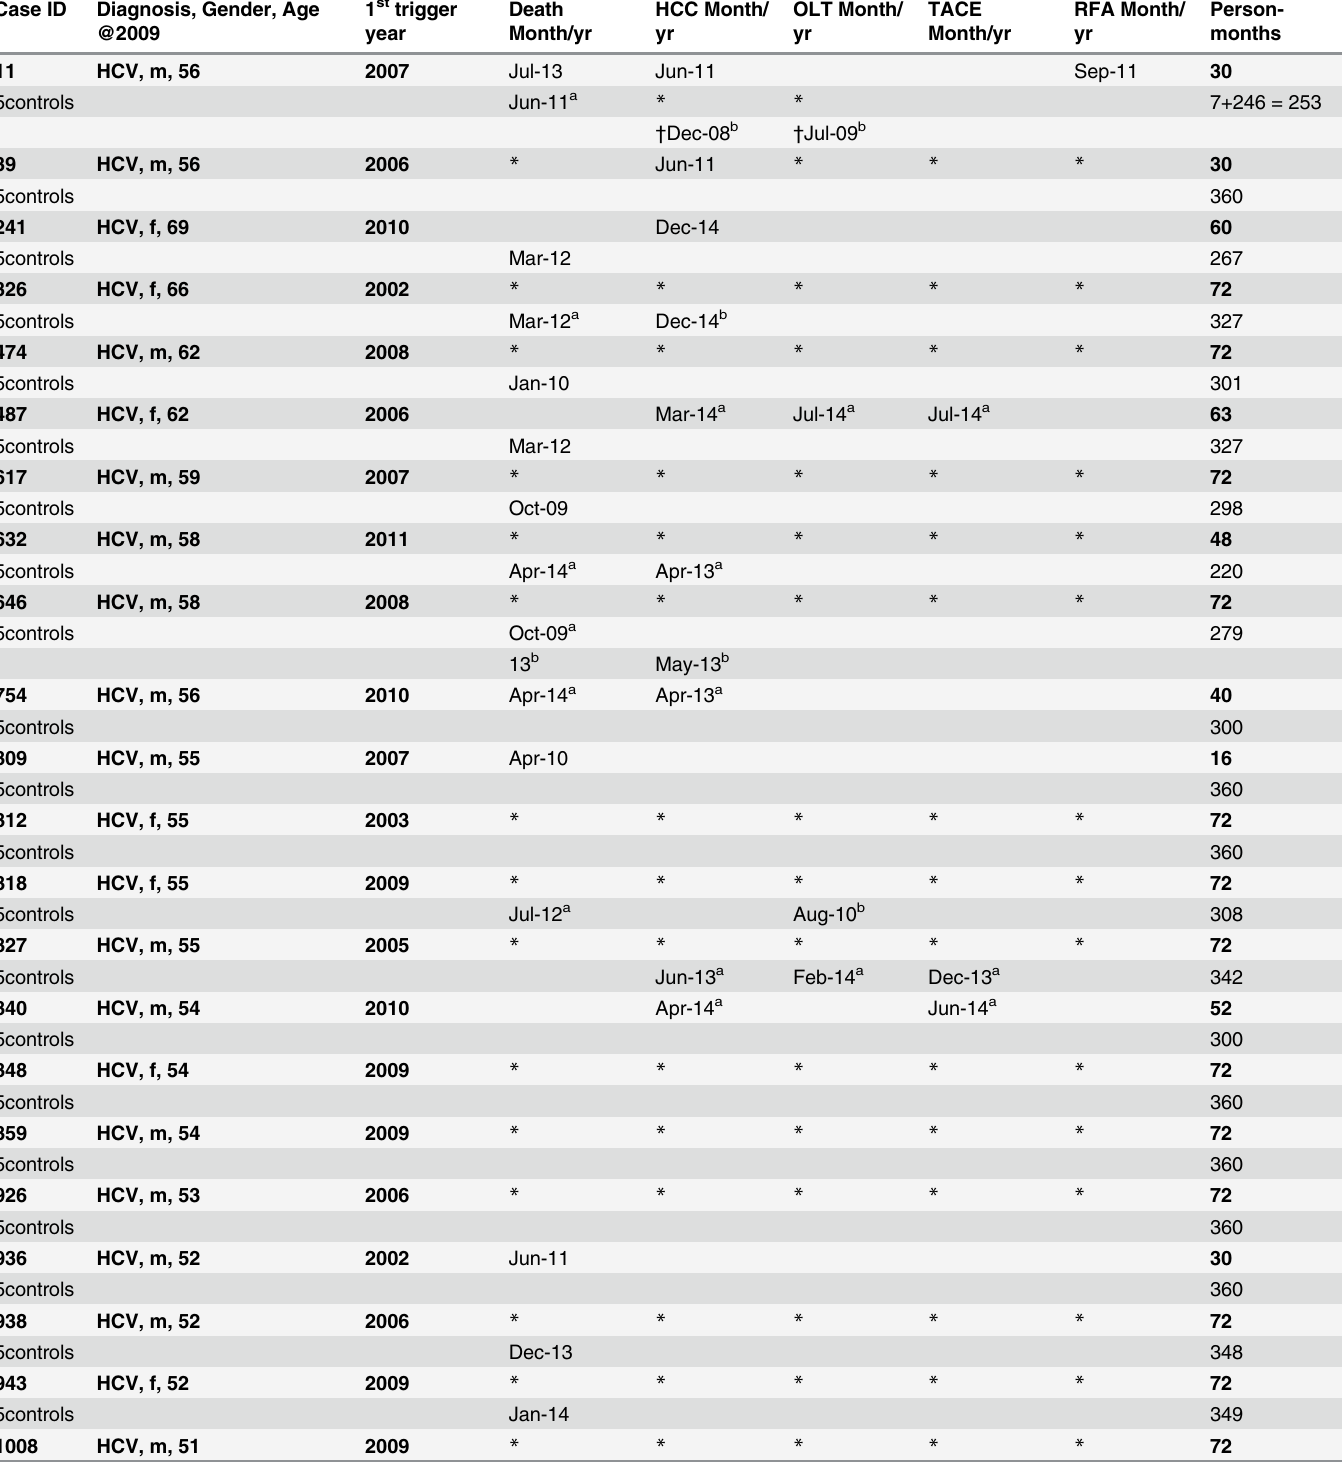
Table 4. Case-controls study assessing the performance of our dynamic Bayesian algorithm for identifying HCV cases at higher risk of HCC-diag- nosis during 2009 –